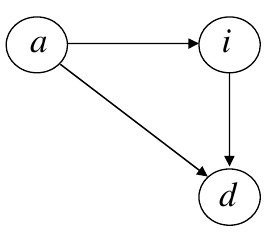
Figure 2. The three-state